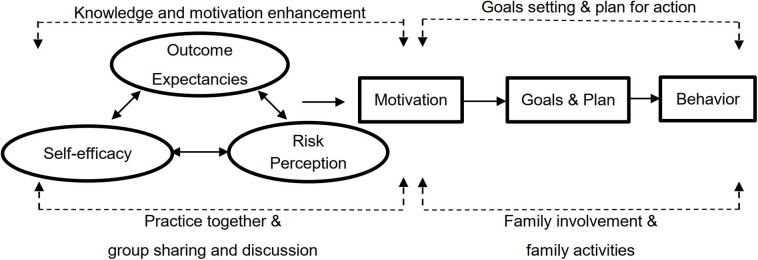
The essential components and strategies of the theory-based intervention.